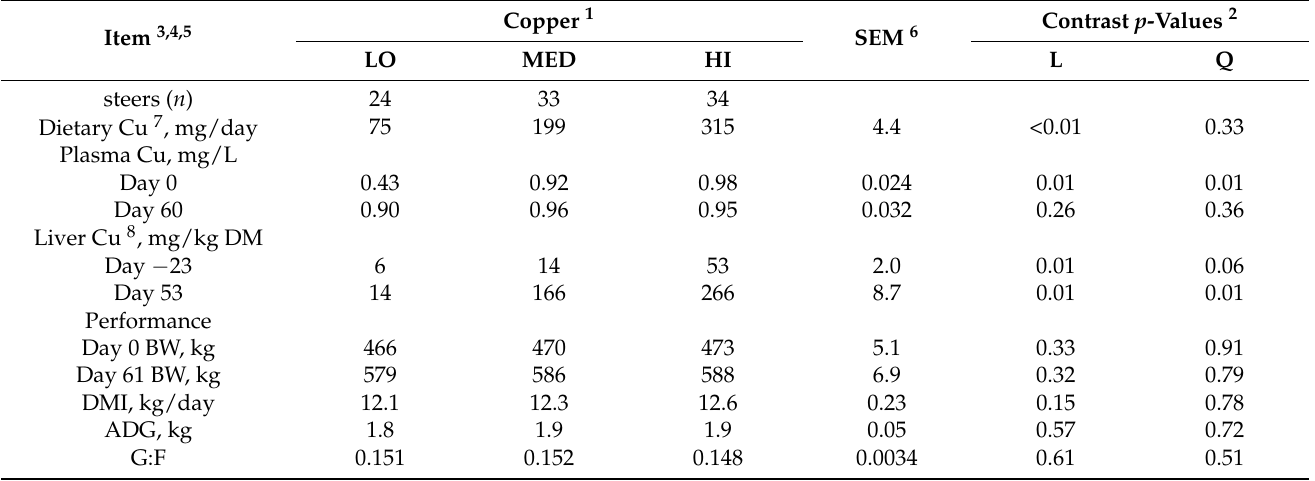
Table 3. Effect of supplemental copper on copper status and performance of steers during pre-beta agonist